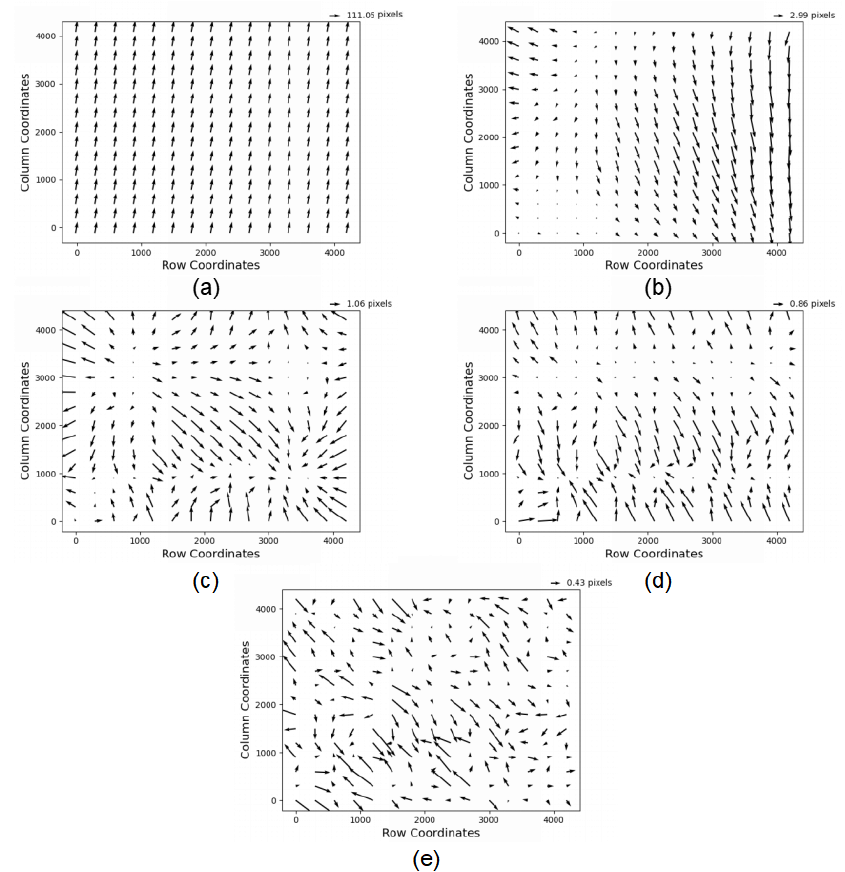
Figure 7. Error distribution of different methods of the 0517-Weihai-50 image: ( a ) no compensation, ( b ) offset compensation, ( c ) affine transform compensation, ( d ) object – space bias compensation, ( e ) the model in this paper.